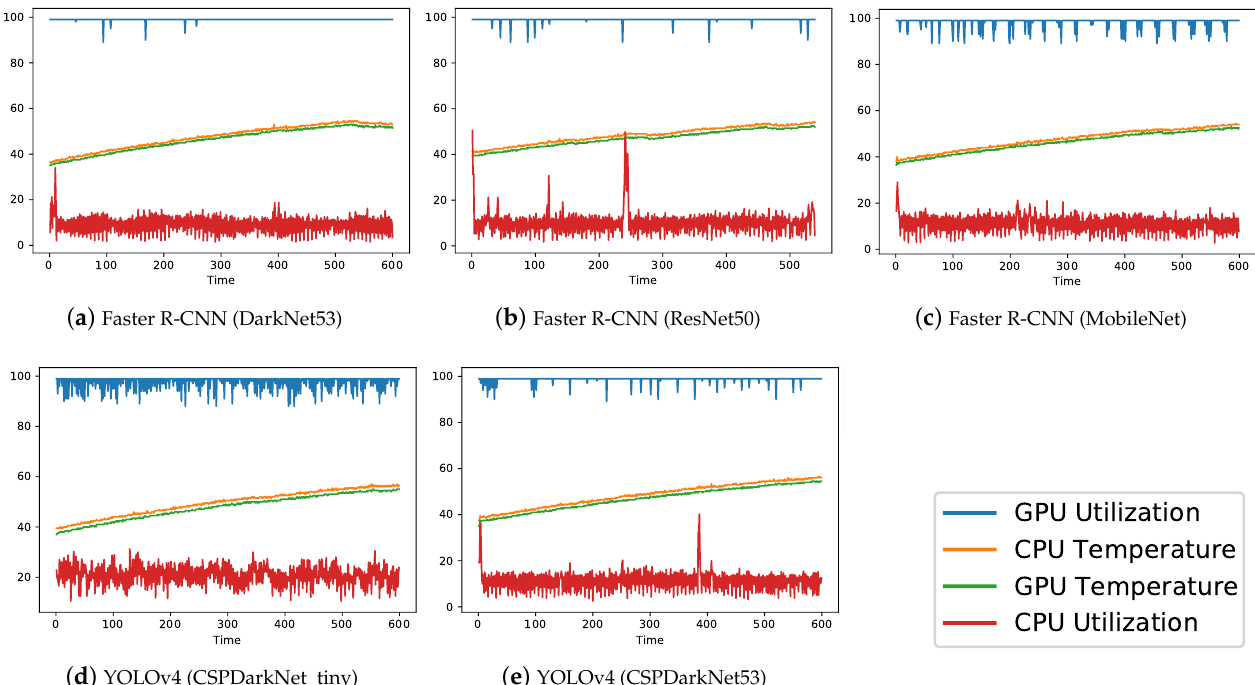
Figure 10. NVIDIA Jetson Nano system usage plots for different variants of implemented computer vision object detection models.